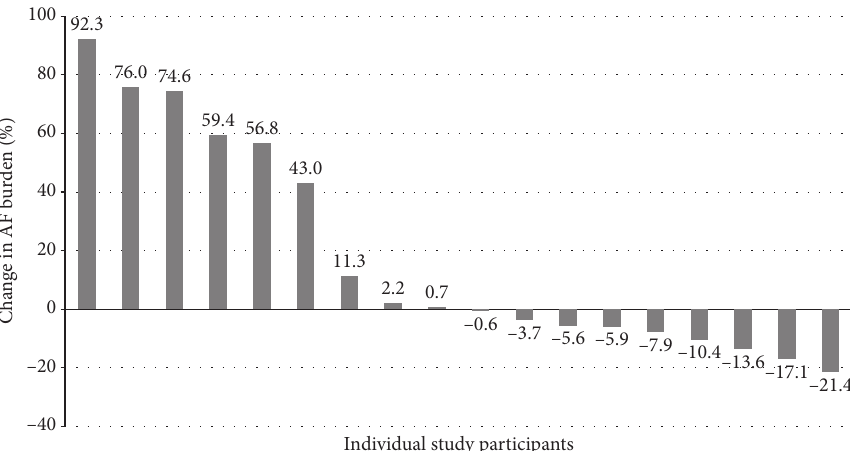
Figure 2: Individual change in atrial fibrillation burden between the first and last Holter-ECG recording. Each bar represents one participant. Only participants with a significant increase or decrease in atrial fibrillation burden are